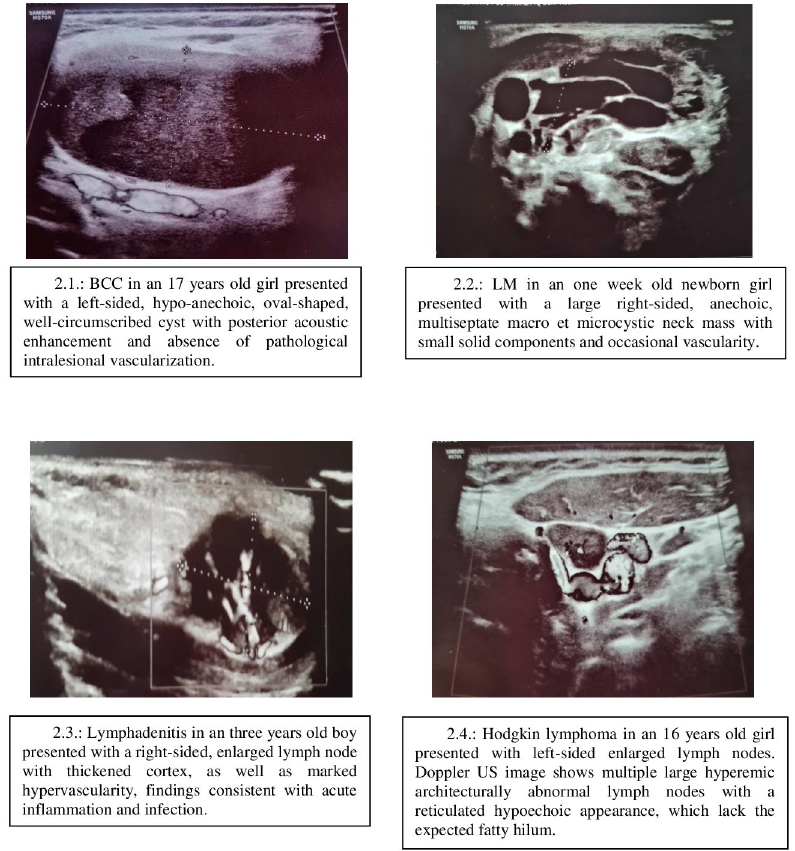
Fig 2. Images of lateral neck masses ultrasound findings (BCC-branchial cleft cyst; LM-lymphatic malformations; US-ultrasound).